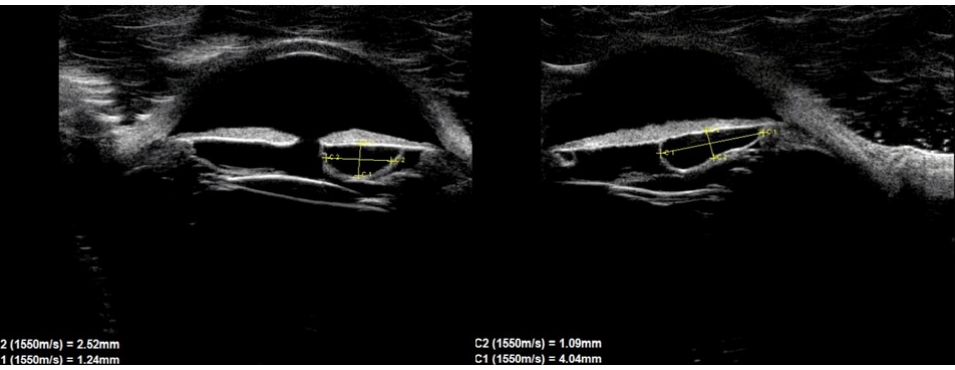
Figure 4. Large cyst covering all zones of iris.